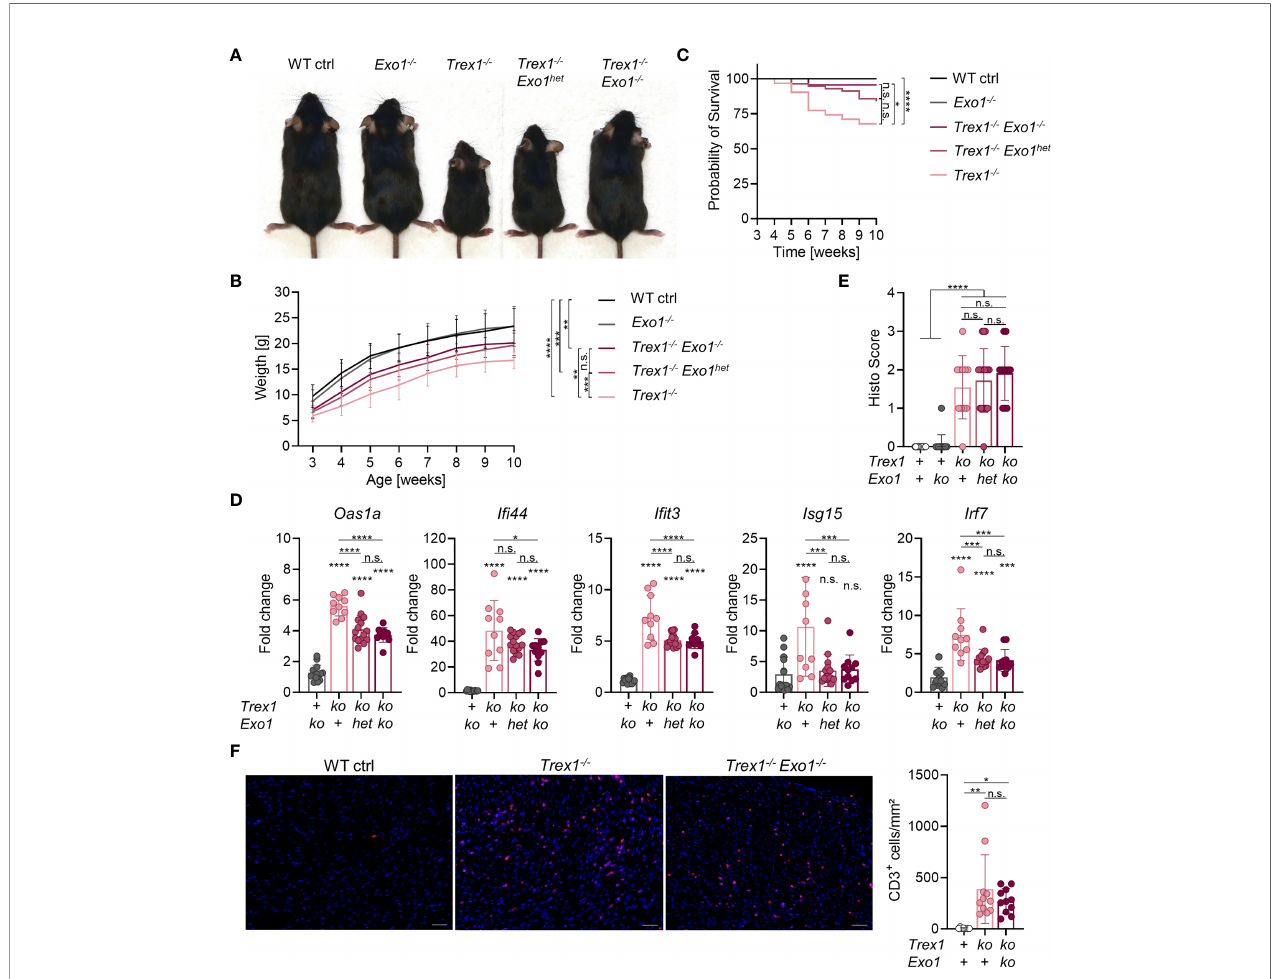
FIGURE 4 | Partial rescue of the Trex1 in fl ammatory phenotype by additional inactivation of Exo1 . (A) Macroscopic phenotype of 7-8 week-old mice of the indicated genotype. (B) Body weight of animals of the indicated genotype (WT n = 32, Exo1 -/- n = 20, Trex1 -/- n = 26, Trex1 -/- Exo1 +/- n = 46, Trex1 -/- Exo1 -/- n = 15). Statistical analysis was performed for the comparison of body weight at the age of 10 weeks. (C) Survival of mice of the indicated genotype until the age of 10 weeks (WT n = 46, Exo1 -/- n = 31, Trex1 -/- n = 31, Trex1 -/- Exo1 +/- n = 56, Trex1 -/- Exo1 -/- n = 22). (D) ISG transcript levels in total blood cells from 6 week-old mice of the indicated genotypes quanti fi ed by qRT-PCR. Fold change compared with mean of WT controls (n = 15) is shown ( Trex1 -/- n = 10, Exo1 -/- n = 14, Trex1 -/- Exo1 WT/- n = 15, Trex1 -/- Exo1 -/- n = 11). See Figure S4 for expression of additional ISGs. (E) Quanti fi cation of in fl ammatory in fi ltration on H&E-stained sections of heart tissue from 10-12 week-old mice of the indicated genotypes. (F) Immunohistochemical staining of CD3 on sections of heart tissue from 10-12 week-old mice of the indicated genotypes (left). Scale bar 50 µm. Quanti fi cation of CD3 + cells per area of heart muscle by investigator-blinded automated image analysis (right). ****p < 0.0001, ***p < 0.001, **p < 0.01, *p < 0.05, n.s., not signi fi